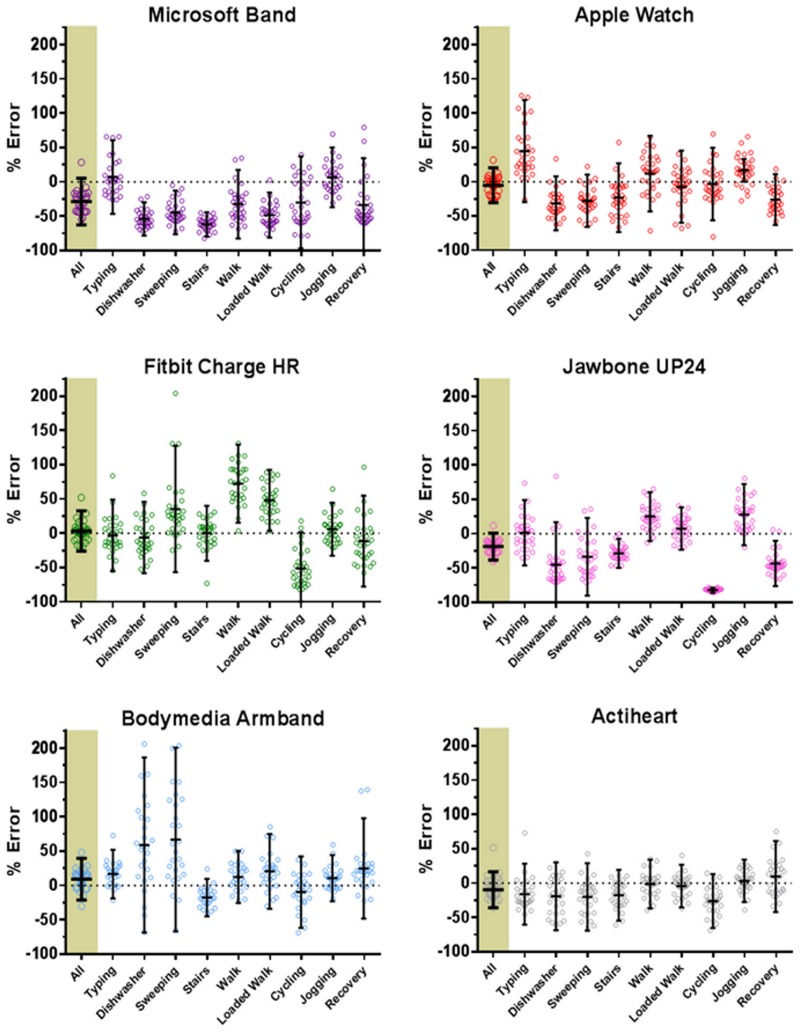
Percentage error of estimation of laboratory activities.Modified box and whisker plot depicting the percentage error of estimation relative to criterion indirect calorimetry for each activity undertaken. The highlighted ‘All’ data furthest left represents the combination of all the activities and recovery periods considered as a whole block. Recovery data represents the combination of the 5 minute stationary recovery periods after the 10 minute walk, loaded walk, cycle and jog periods. Small circles represent the individual data points, with horizontal bars representing the mean for each activity bordered by the 95% limits of agreement.